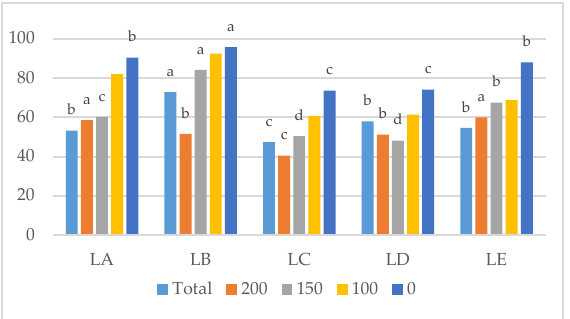
Figure 1. Survival of alfalfa five lines measured after 10 weeks on culture medium enriched with 0, 100, 150 and 200 mM NaCl. The histograms represent the average of 20 replicates. The different letters show the statistical differences among the varieties for each salt treatment. (Test SNK- p ≤ 0.01). Table 1. Indexes of salt sensitivity (IS) estimated based on the total fresh biomass of five alfalfa lines grown for 10 weeks on a basal medium enriched with different salt concentrations. Data represent the average of 20